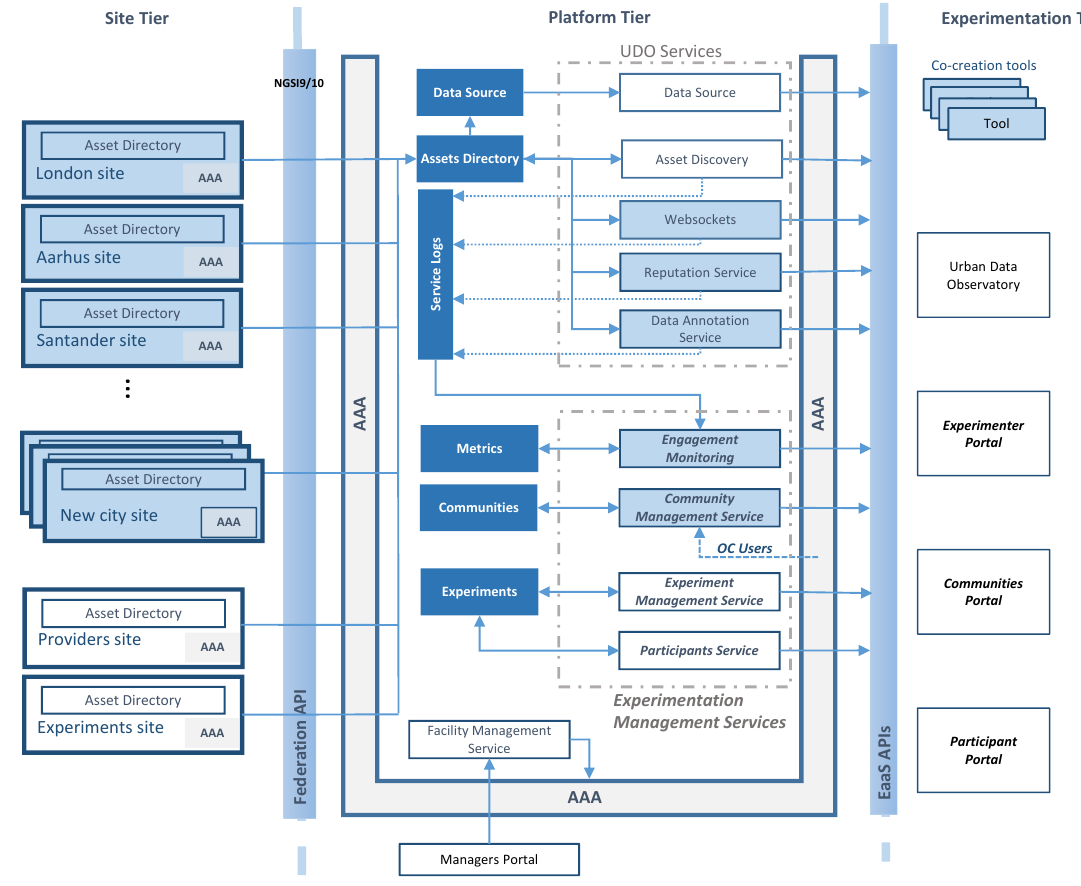
Figure 1. Overarching description of the OrganiCity EaaS